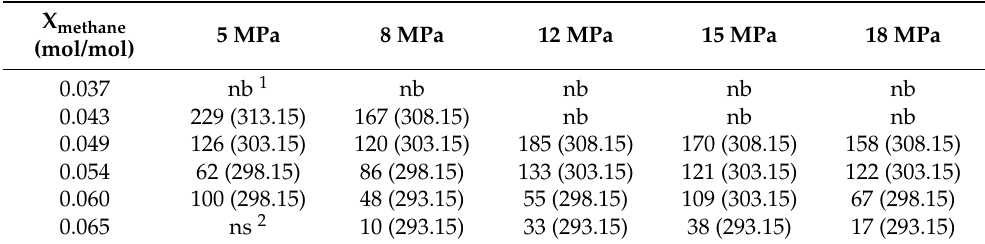
Table 2. The times and corresponding temperatures for the generation of methane gas bubbles in each